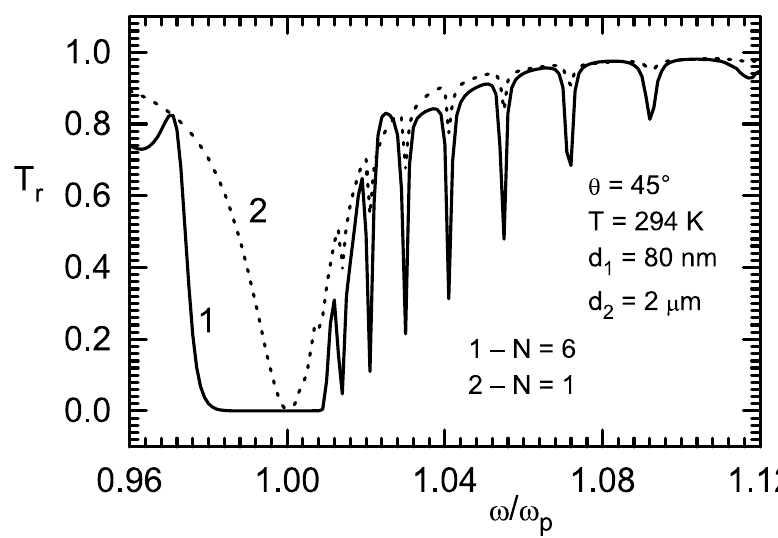
Figure 5. Transmittance T r as a function of the relative frequency ω / ω p for the quantum electron plasma at the incidence angle θ = 45 ◦ , temperature T = 294 K, graphite layer thickness d 1 = 80 nm, and quartz layer thickness d 2 = 2 µ m, for various graphite layer numbers: 1 − N = 6 (solid line); 2 − N = 1 (dotted line).